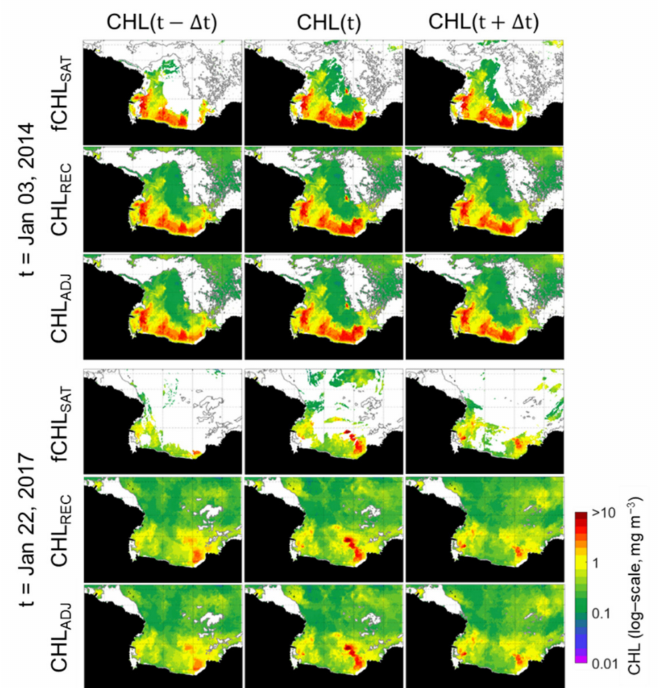
Figure 9. Spatial distribution of fCHL SAT , CHL REC and adjusted CHL REC (CHL ADJ ) for 3 consecutive days (upper panels: t = 3 January 2014; lower panels: t = 22 January 2017). Thick gray lines in the CHL spatial distribution are the contours of 60% sea ice concentration (SIC); regions with more than 60% SIC were masked in the distribution of the CHL REC from the RF model.